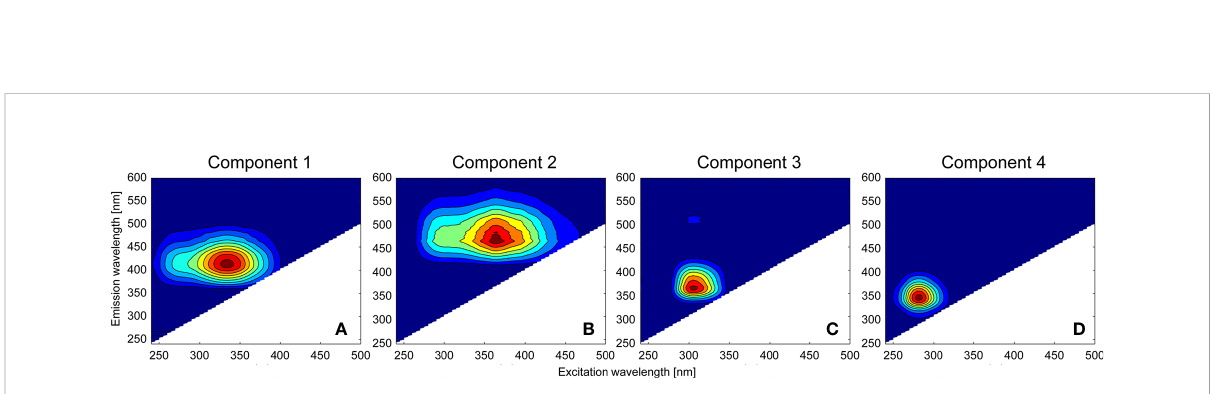
FIGURE 3 Excitation – emission matrix spectroscopy contour plots of four components [C1 (A) , C2 (B) , C3 (C) , and C4 (D) ] determined by the parallel factor analysis model.